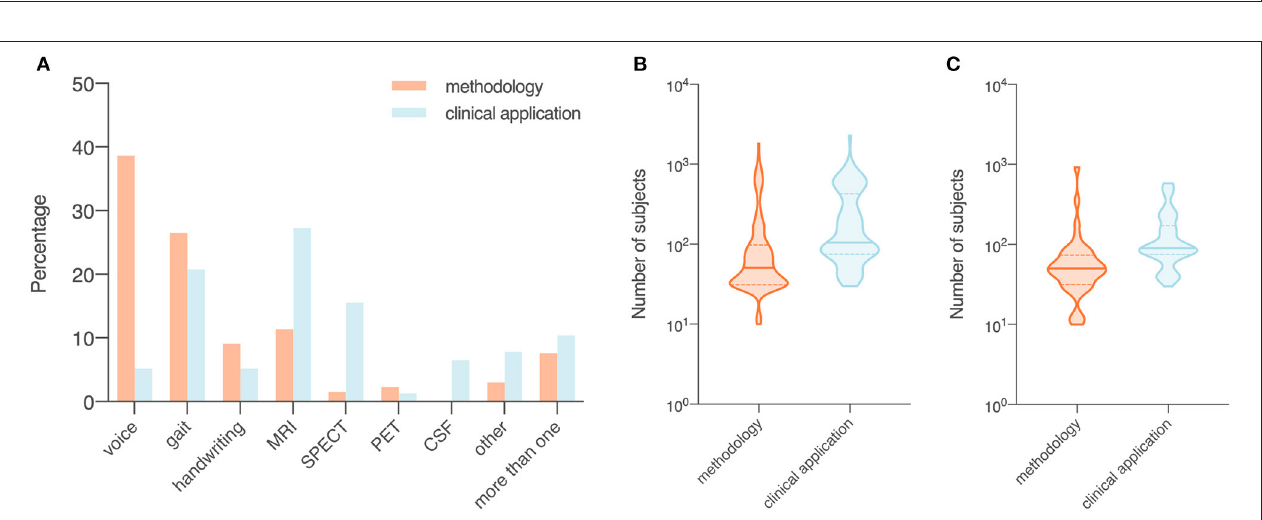
FIGURE 2 | Sample size of the included studies. (A) Cumulative relative frequency graph depicting the frequency of the sample sizes studied. (B) Histogram depicting the frequency of a sample size of 0–50, 50–100, 100–200, 200–500, 500–100, and over 1,000 for studies using locally recruited human participants and studies using previously published open databases. Green, studies using locally recruited human participants; gray, studies using data sourced from public databases. (C) Model performance as measured by accuracy in relation to sample size, shown in means (SD).